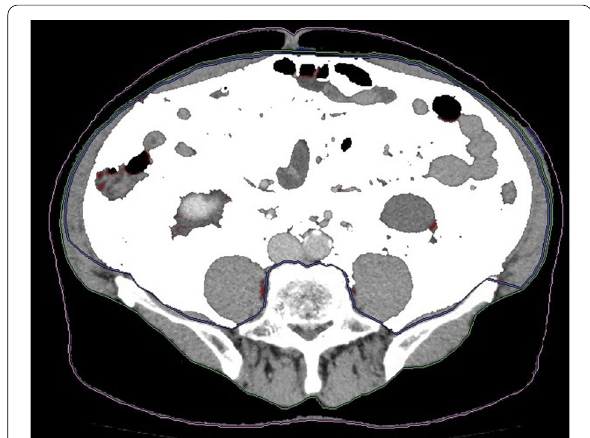
Fig. 1 Computed tomography revealing the degree of fat distribution. The white area within the drawn circle is the visceral fat